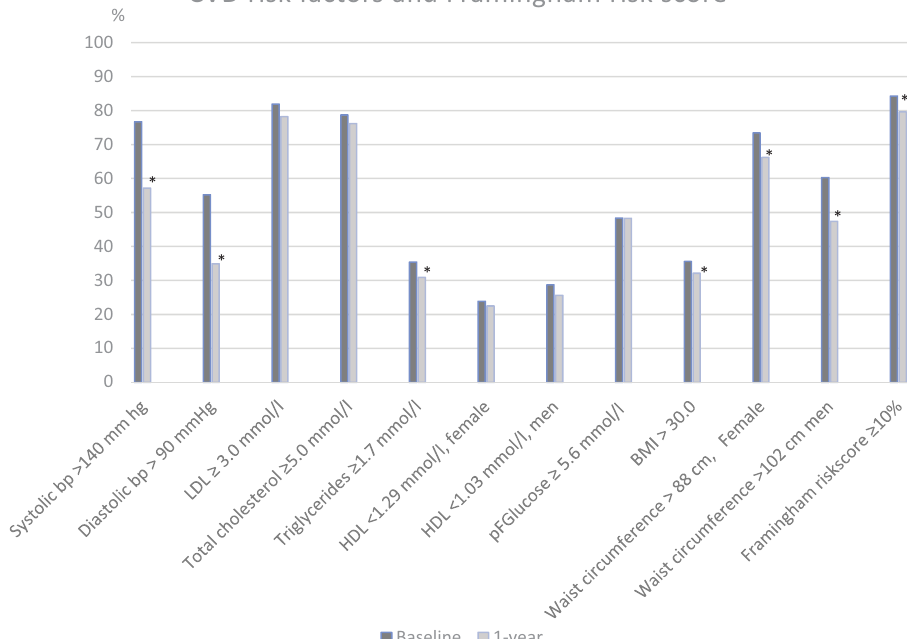
(cid:4) Significantly different from